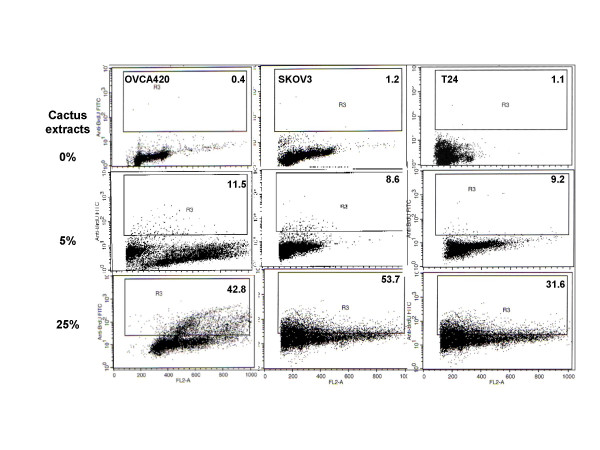
Apoptosis induction analyzed by TUNEL assay in ovarian and bladder cancer cells. TUNEL analysis results showed apoptosis induction by cactus extract in ovarian cancer cells (left and mid-panel) and bladder cancer cells (right panel).